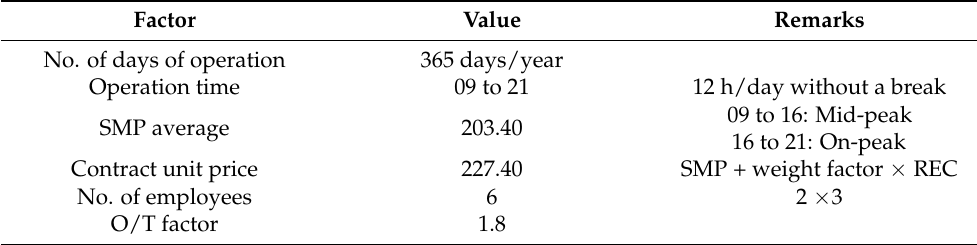
Table 41. Factors and their values are subject to the operation plan (Scenario VII).